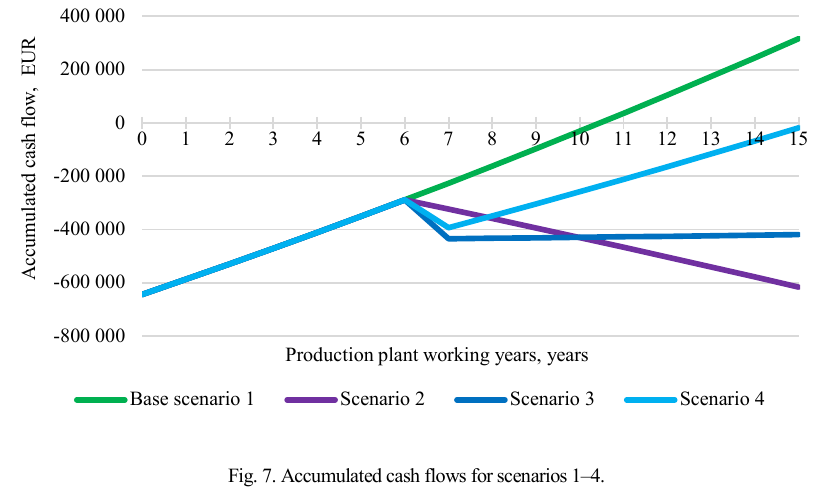
Fig. 7. Accumulated cash flows for scenarios